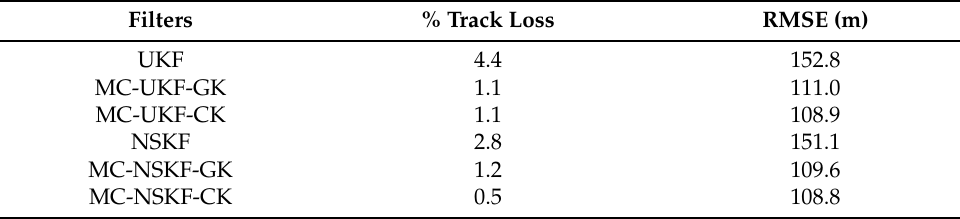
Figure 9. 2D: RMSE in position. Table 3. 2D: RMSE in position and % Track Loss.